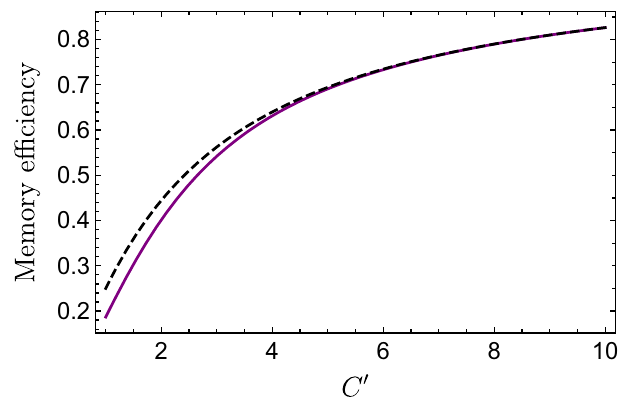
FIG. 7. Memory efficiency as a function of the resonator effec- tive cooperativity. The solid line shows the efficiency given by Eq. (4) assuming t s = t r = 1 / 2 γ e . The dashed line corresponds to t r → ∞ [i.e., η = C (cid:7) 2 /( 1 + C (cid:7) ) 2